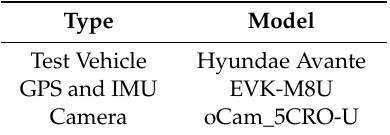
Table 2. Test vehicle and sensor specifications.